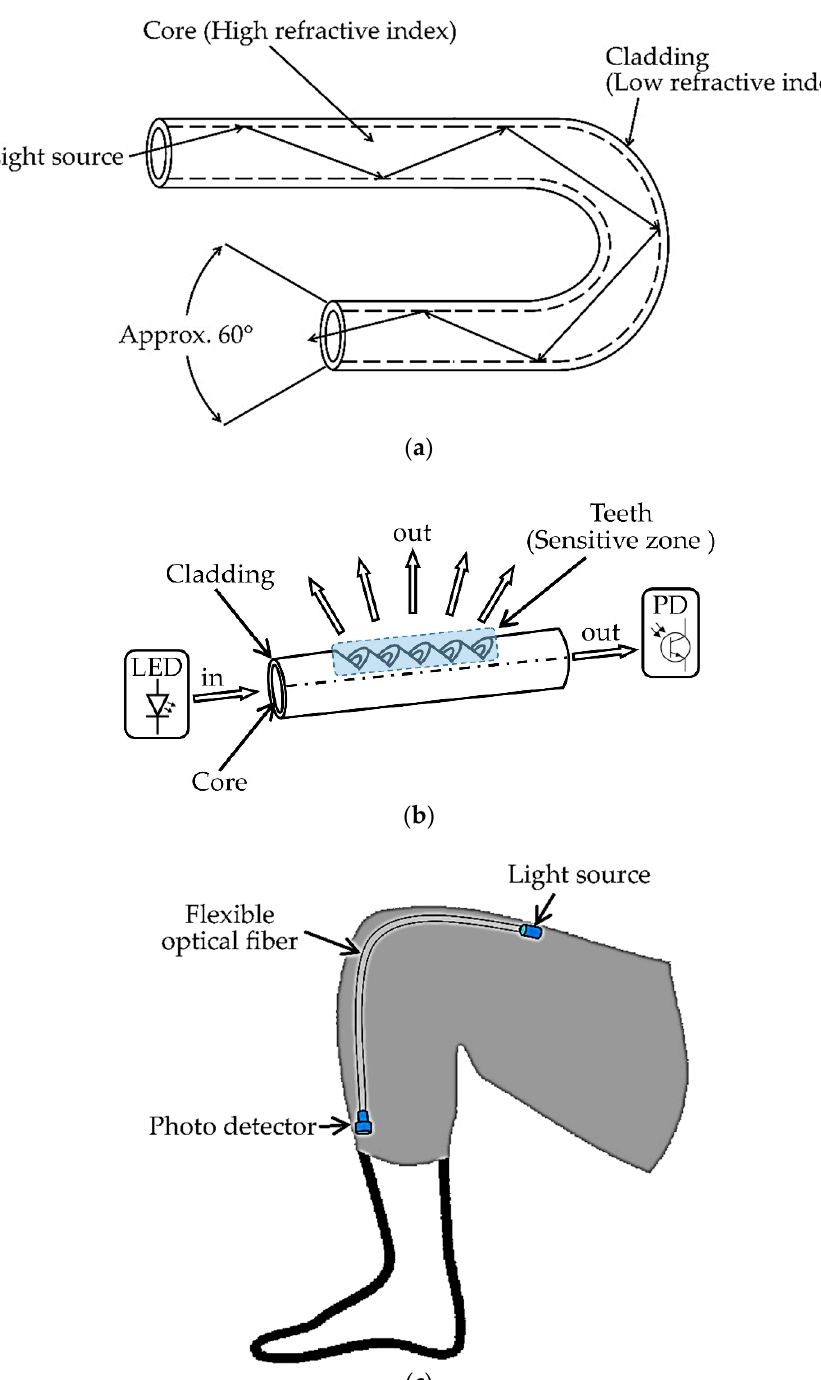
Figure 5. ( a ) Optical fiber configuration and working principle; ( b ) construction and operation method of the fiber-optic curvature sensor with a “teeth-like” sensitive zone; ( c ) flexible optical fiber sensors (OFS)-based joint monitoring system configuration.